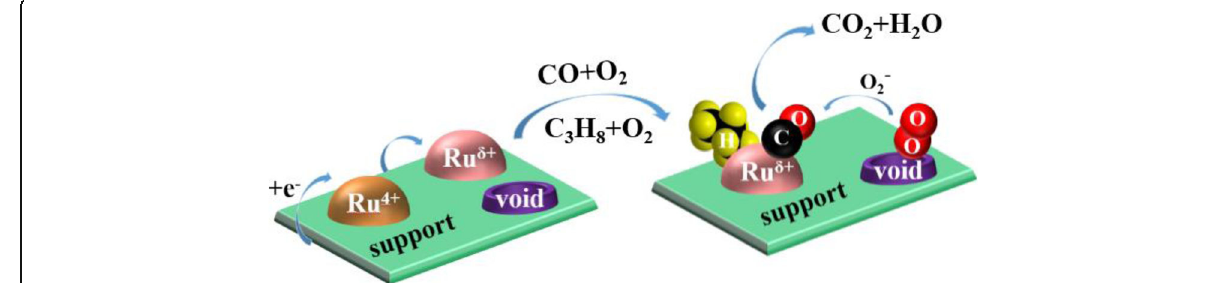
Fig. 12 Possible reaction mechanism of CO and C 3 H 8 over Ru/Sn x Ti 1 − x O